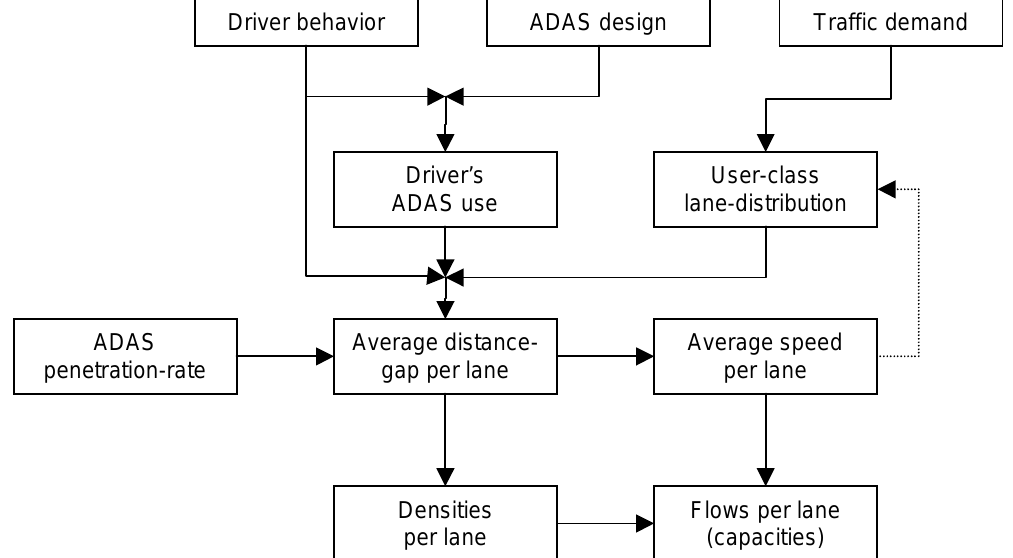
Figure 1. Causal diagram of factors affecting flow levels and flow distribution on motorways (from Minderhoud